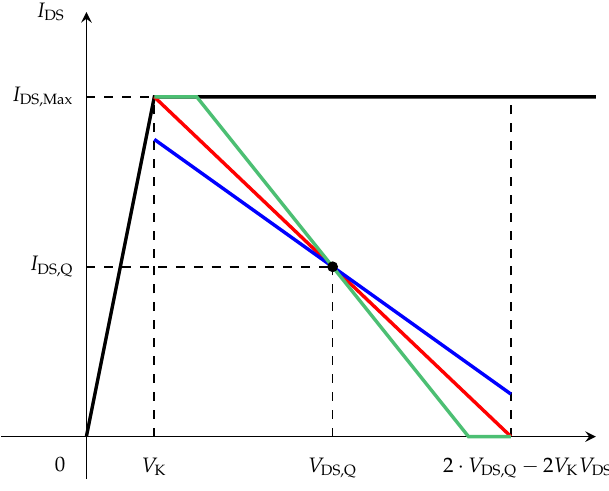
Figure 9. Load-lines for a TL class-A PA with R Lopt sized at different β x : β x = 1 (max. swings without clipping, red), β x < 1 (limited current swing, blue), β x > 1 (current clipping,